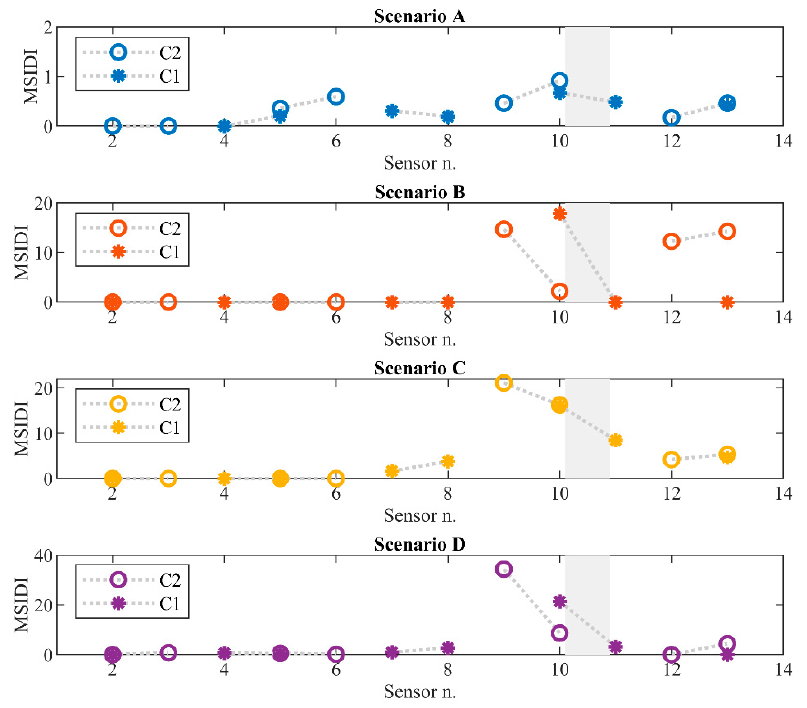
Figure 12. S101 bridge: Damage indexes for different damage scenarios and sensor subset configu ‐ rations. The grey bars highlight the damage location.